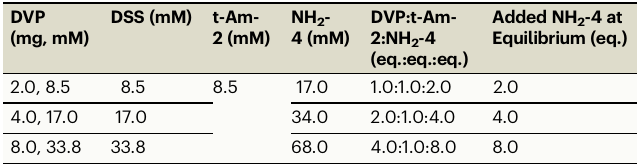
Table 1 | Autonomous cycle reactant